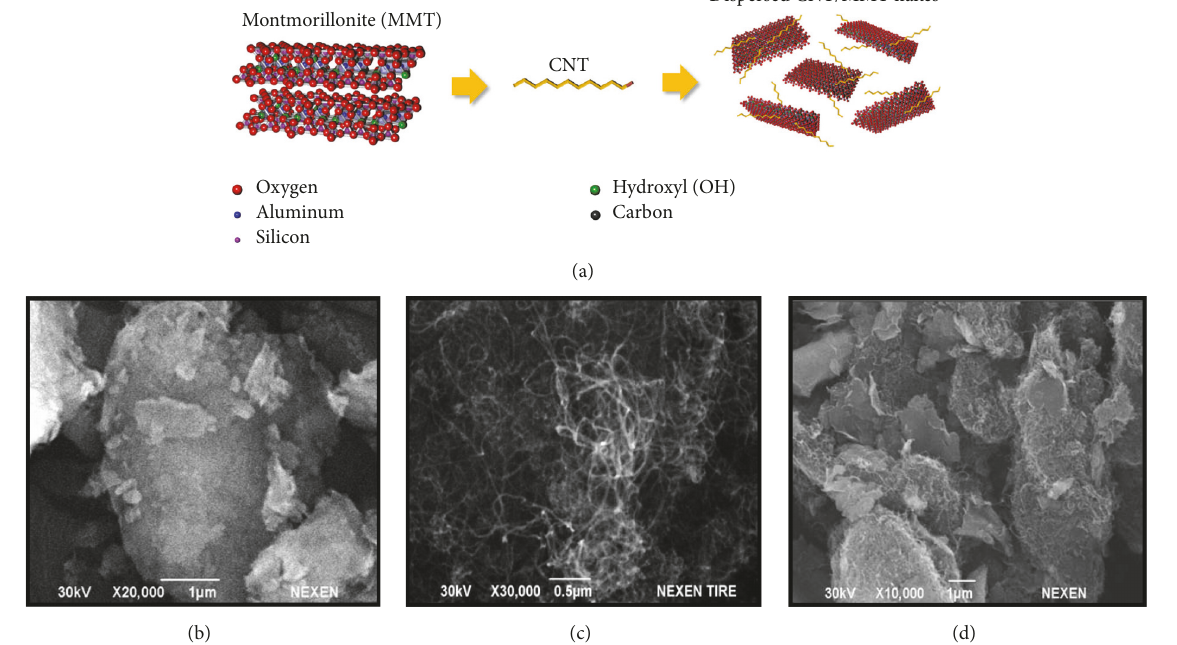
Figure 1: (a) Schematic diagram showing the overall processing of fabricated MMT/MWNT; ((b), (c), and (d)) SEM images of the MMT, MWNT, and MMT/MWNT,